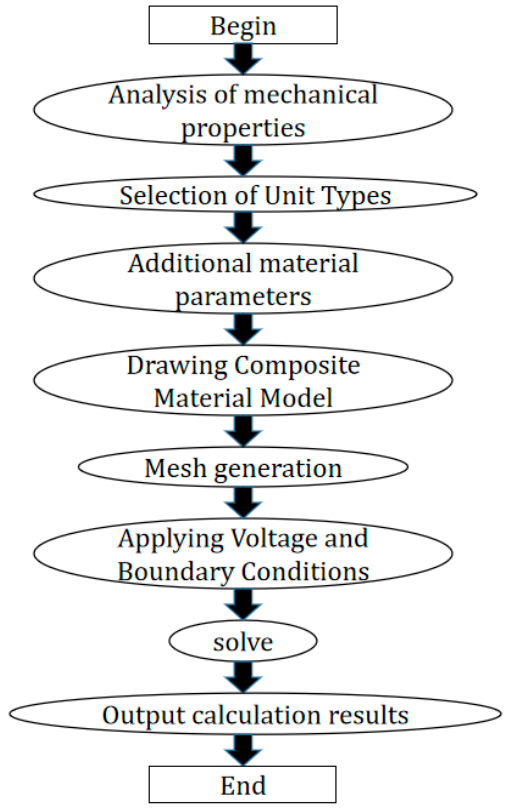
Figure 2. Simulation flow chart of ANSYS finite element software.